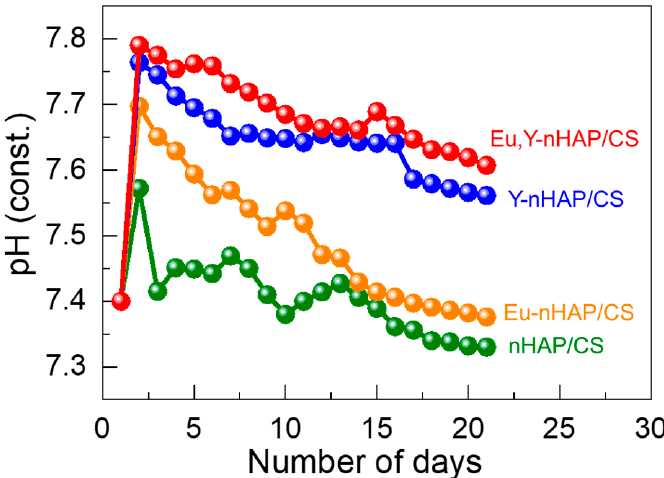
Figure 4. Comparison of the pH levels for the nHAP/CS, Eu-nHAP/CS, Y-nHAP/CS, and Eu,Y- nHAP/CS composites immersed in SBF for 21 days.